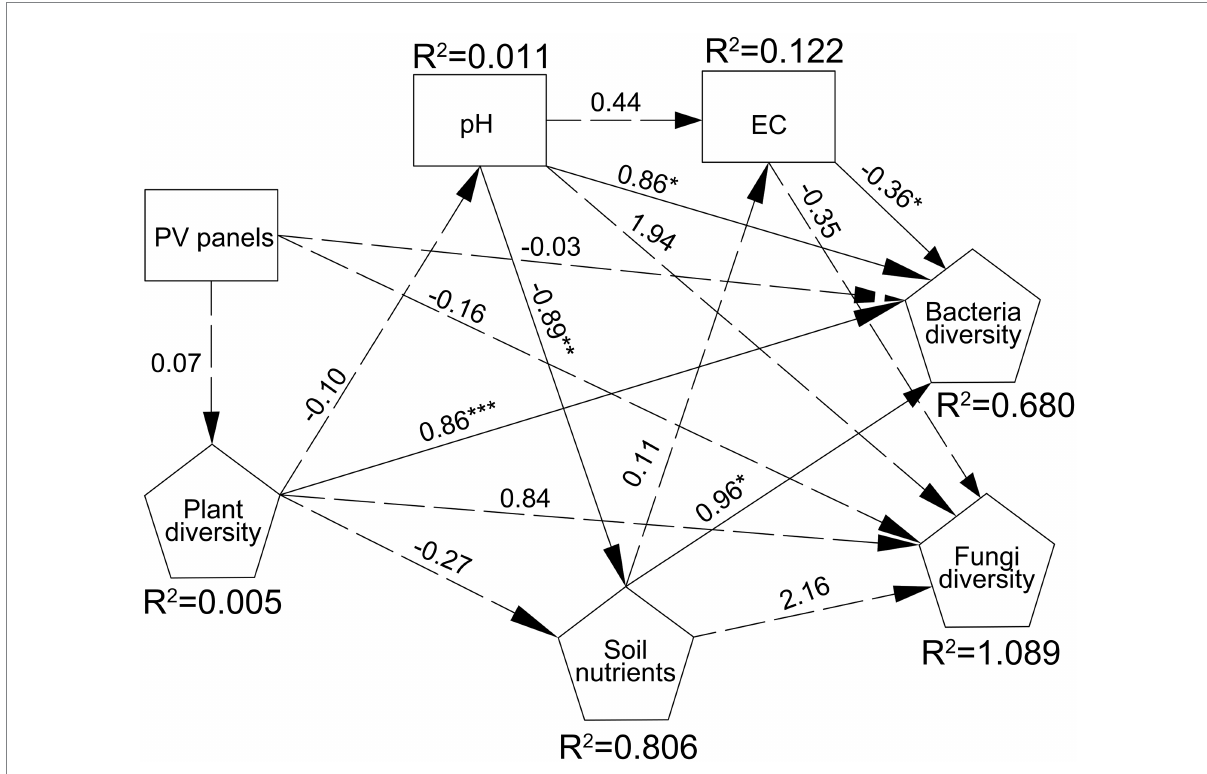
FIGURE 5 SEM model of the interaction between plant communities, soil properties and soil microorganisms (p = 0.003, χ 2 /df = 1.036, GFI =0.809, RMSEA =